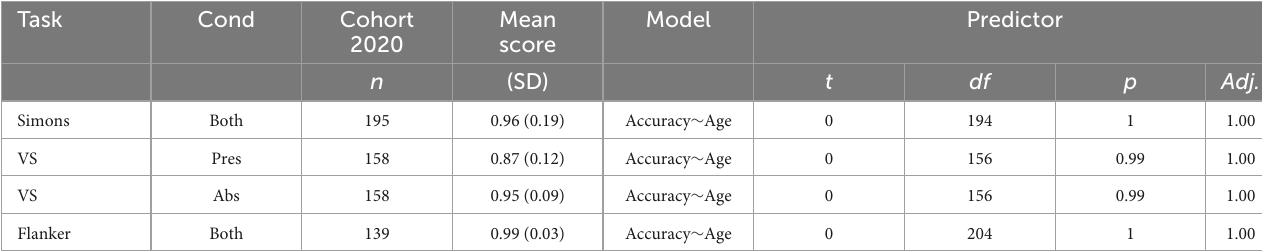
TABLE 2 Age is not associated with